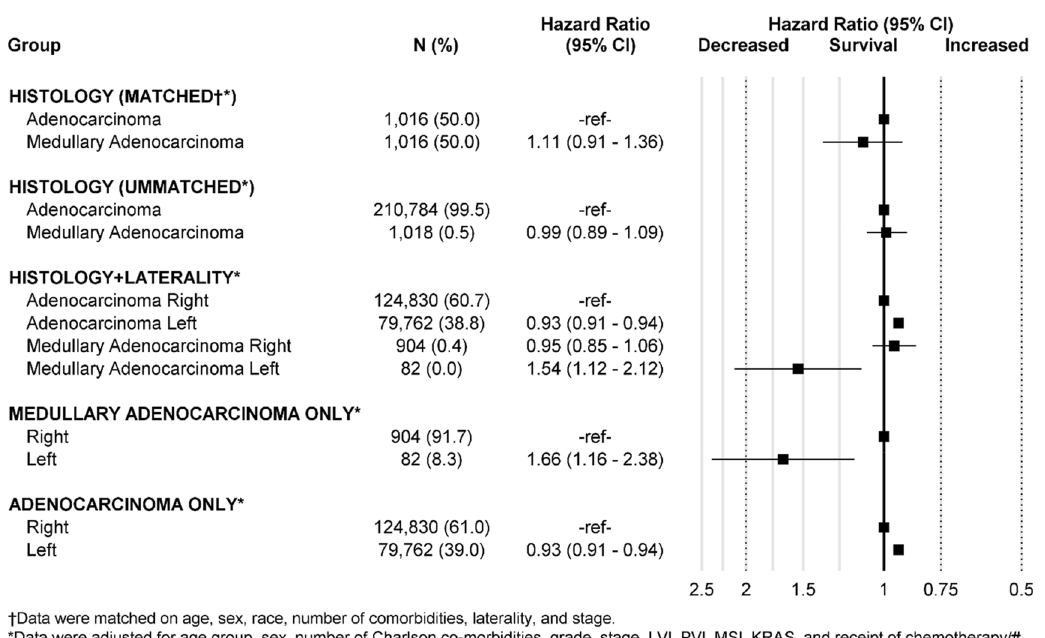
Figure 3. Overall survival by histology and laterality of left and right-sided colon medullary adenocarcinoma and colon